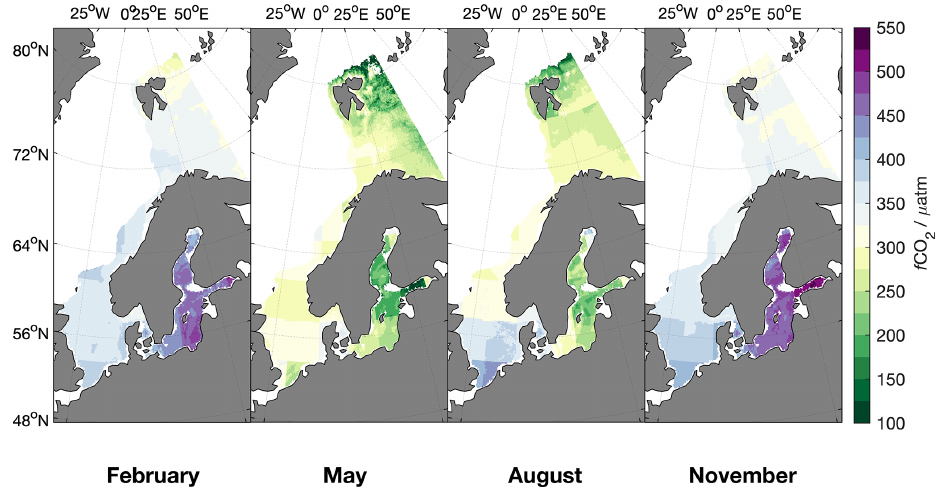
Figure 4. The average f CO 2 of MLR 1 (1998–2016) for 1 example month in each season (February, May, August and November).